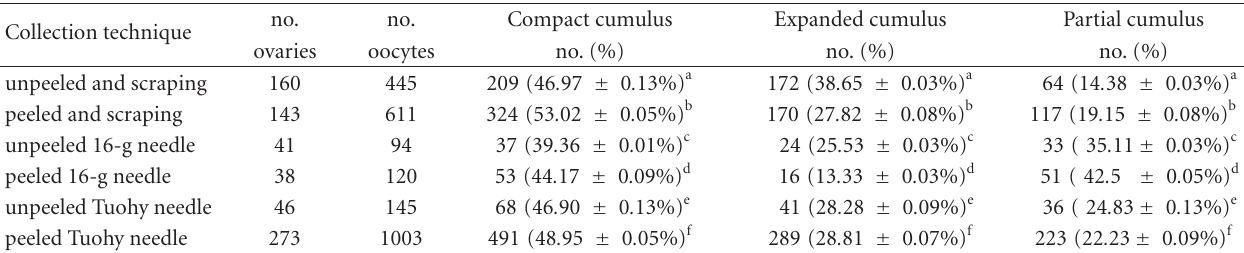
Table 2: Cumulus morphology by di ff erent collection techniques.